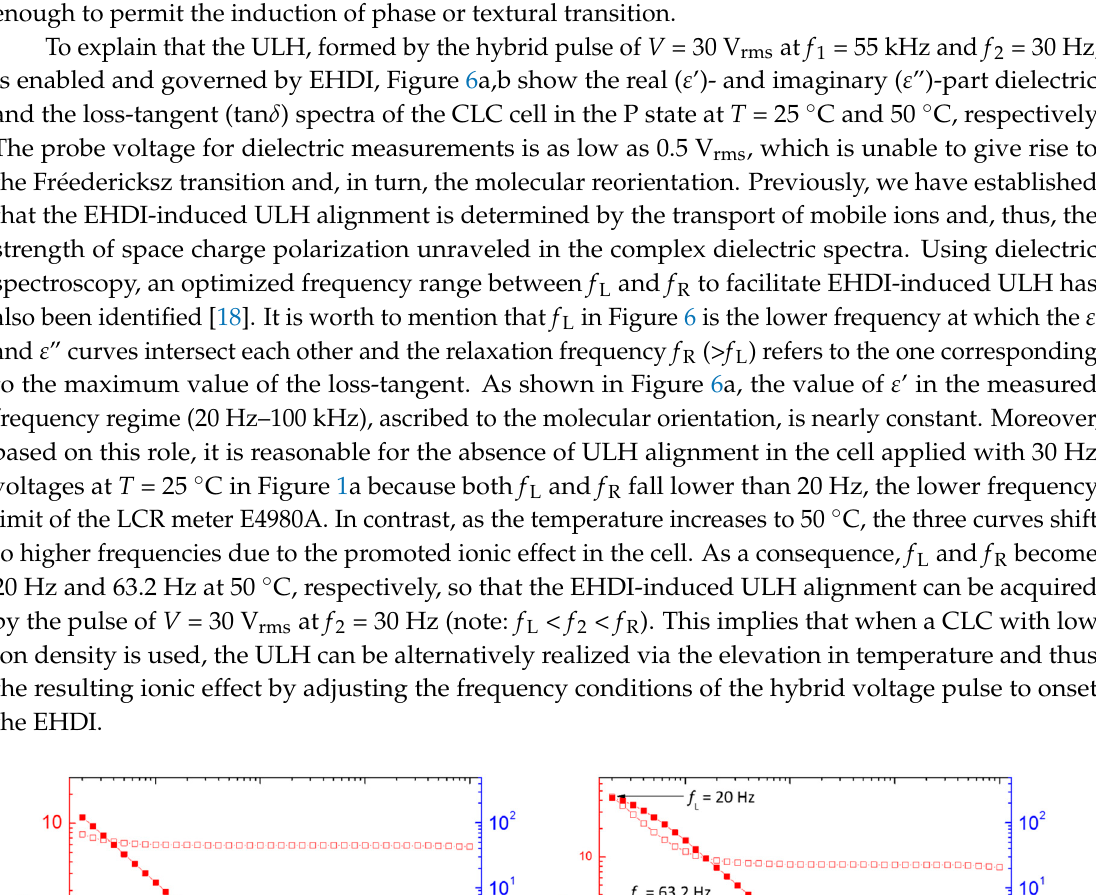
Figure 5. ( a ) Time-dependent transmission curves of the cell after the switching of the frequency of the hybrid pulse from f 1 (= 55 kHz) to f 2 and ( b ) time-dependent temperature and temperature variation of the cell during the application of hybrid pulses at V = 35 V rms and V = 30 Vrms . The duration of the pulse at f 1 is 600 s.